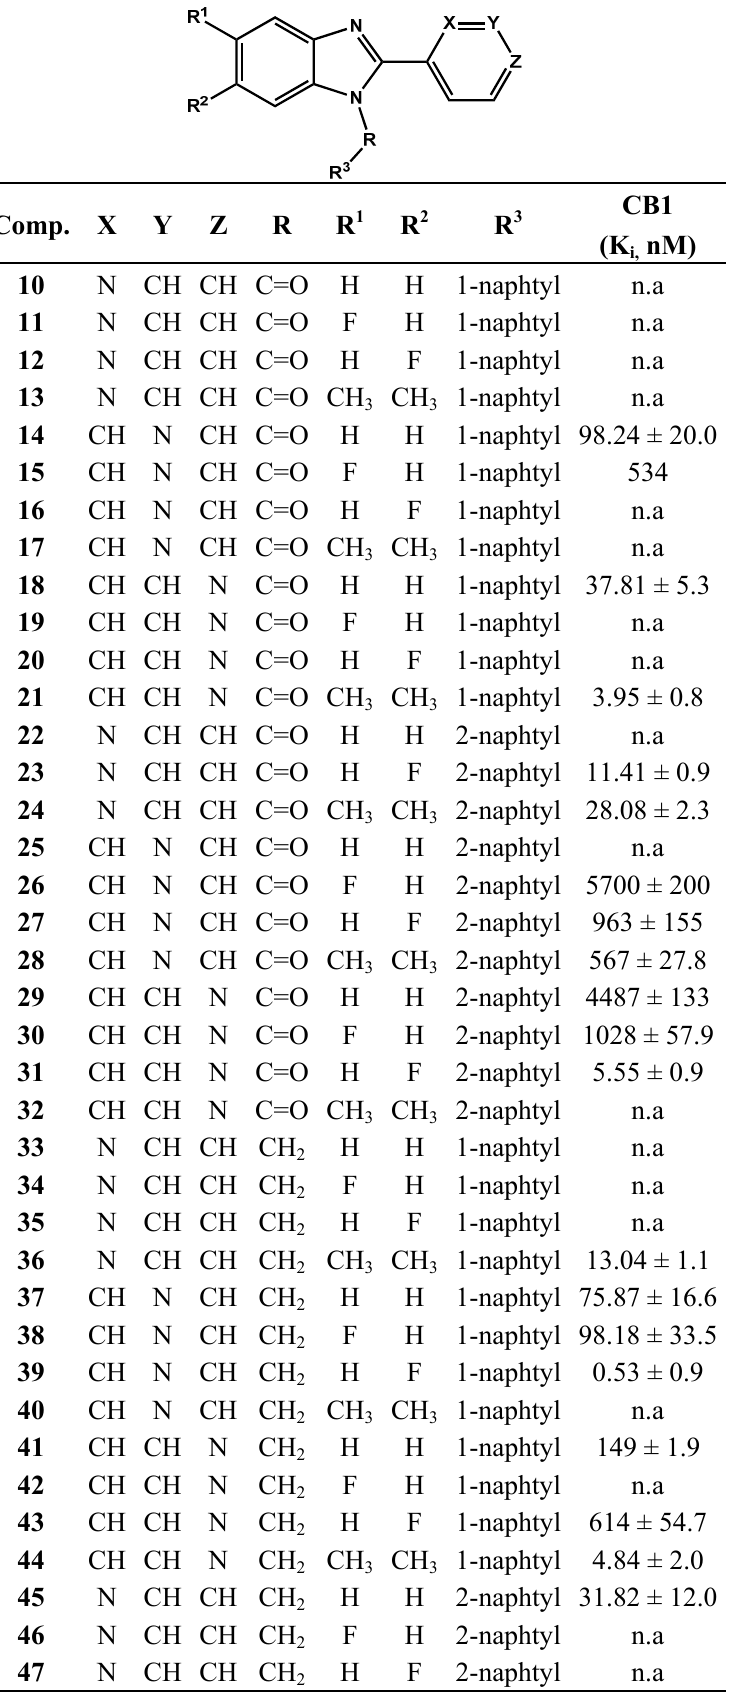
Table 1. Radioligand displacement results for 2-arylbenzimidazoles 10 – 56 a .